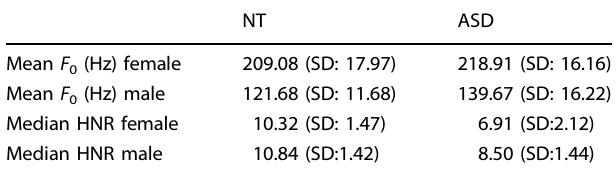
Table 2. Voice characteristics including harmony-noise-ratio (HNR) and fundamental frequency ( F 0 ) in Hertz (Hz) for both